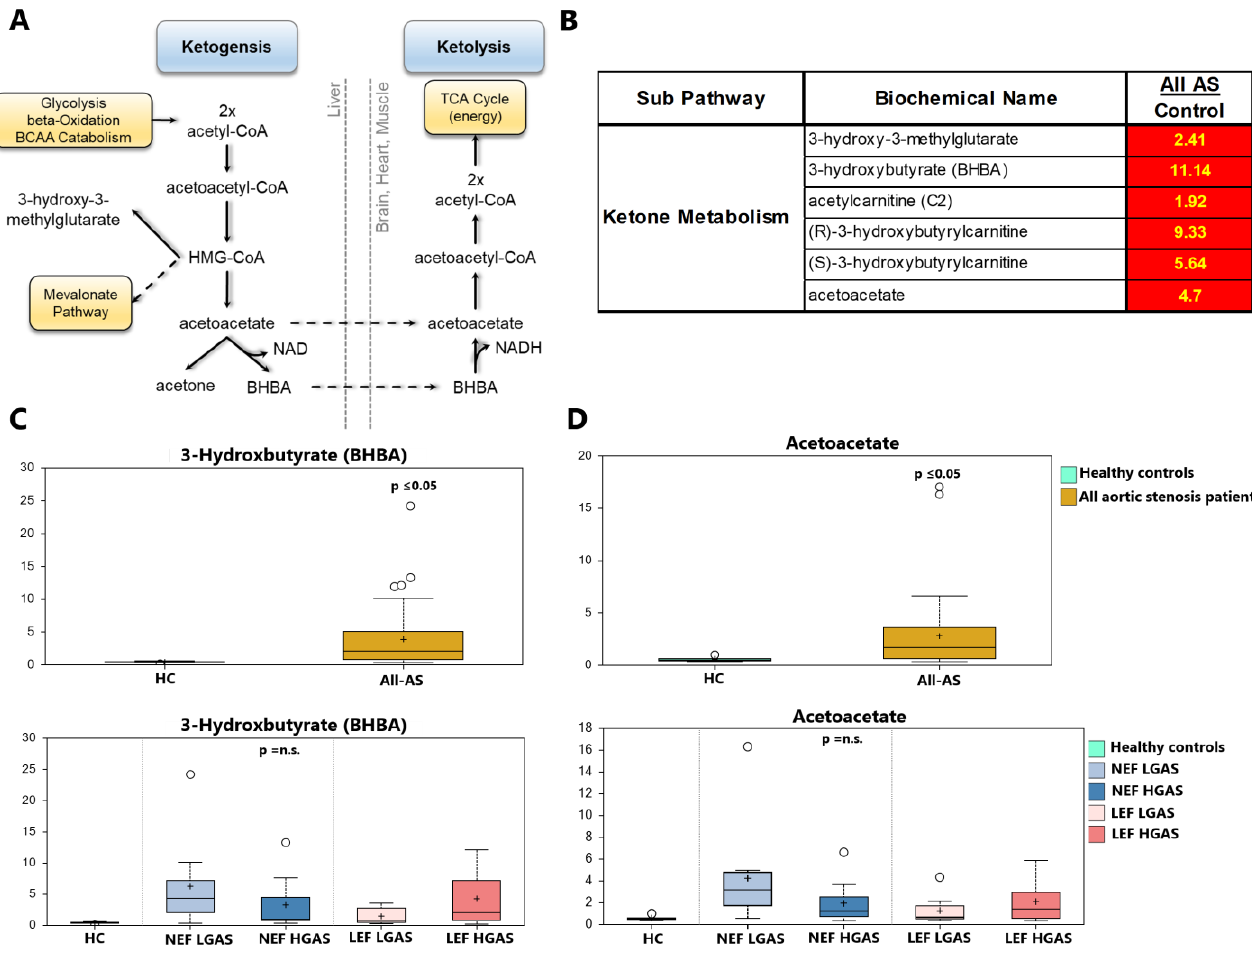
Figure 4. Ketone bodies in AS and healthy controls. ( A ) Illustration of ketone body utilization for energy production via TCA cycle. ( B ) List of significantly altered ketone bodies between All-AS group and controls (significantly regulated molecules marked in red, numbers indicate x-fold increase in concentration). ( C , D ) 3-Hydroxbutyrate (BHBA) and acetoacetate as examples between All-AS vs. controls as well as the different AS subgroups. On each box, the black cross indicates the mean value, the borders and segmentation indicate limits of upper/lower quartile and median values. Outliers are plotted as circles. n.s.: not significant between AS subgroups.